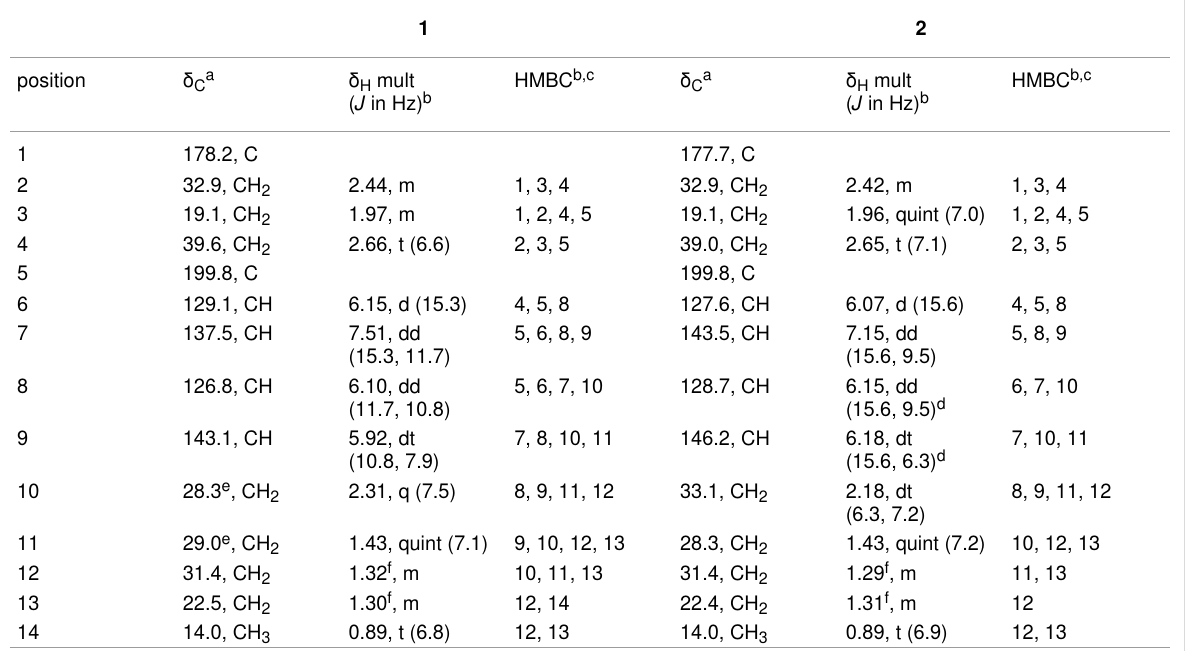
Table 1: 1 H and 13 C NMR data for compounds 1 and 2 in CDCl 3